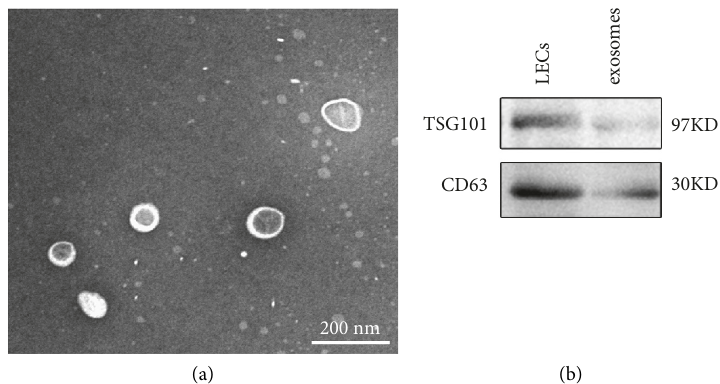
Figure 1: Characteristic of exosomes released from lenses. (a) Transmission electron micrograph of exosomes isolated from ex vivo rat lenses culture media at day 7. Scale bar � 200 nm. (b) CD63 and TSG101 expressed in LECs and exosomes from rat lenses were detected by Western blot.